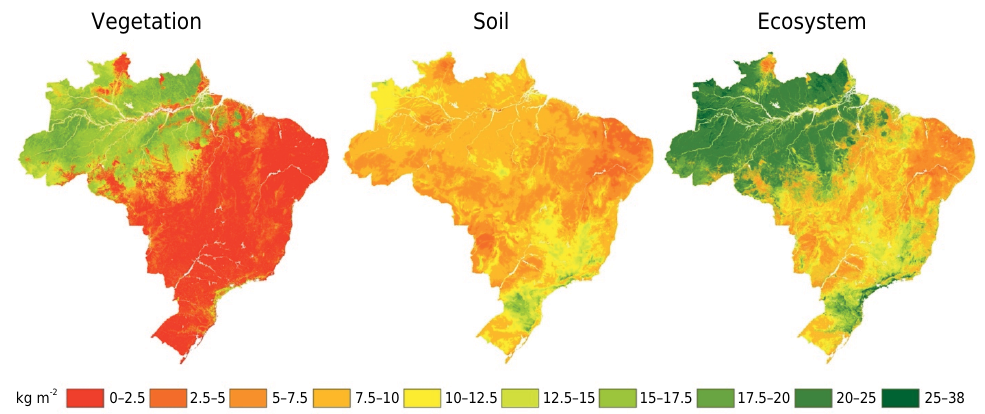
Figure 3. Spatial distribution of vegetation and soil C pools, and their sum to yield the ecosystem C pool in Brazil. The spatial distribution of vegetation C pools has been published by Englund et al. (2017). Soil C pools included observations from more than 8,200 soil profiles as described elsewhere by Gomes et al.